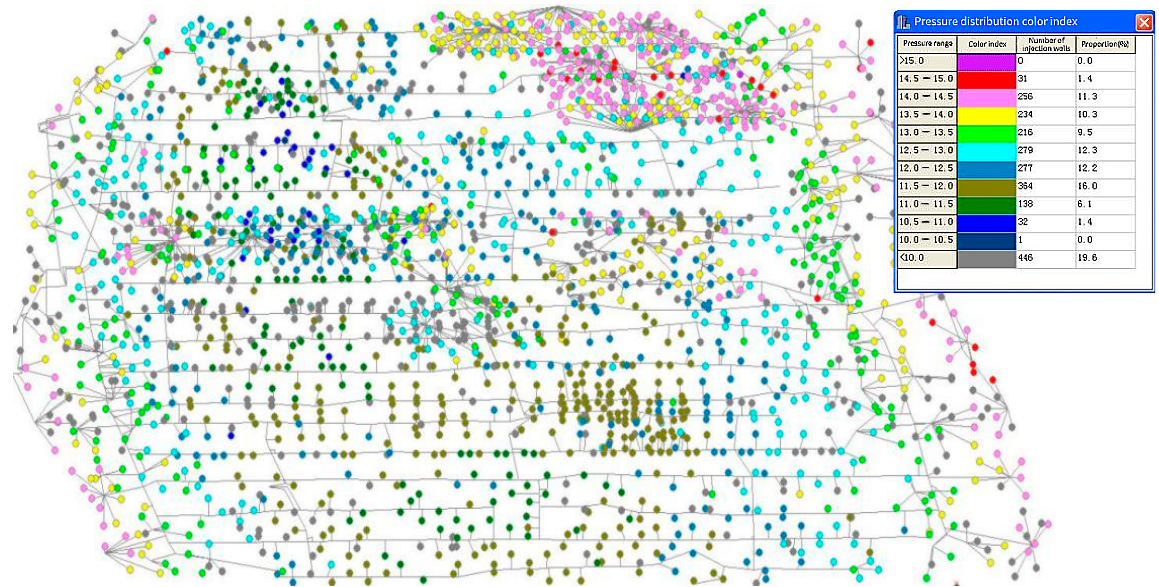
Figure 9. Pressure distribution of flooding